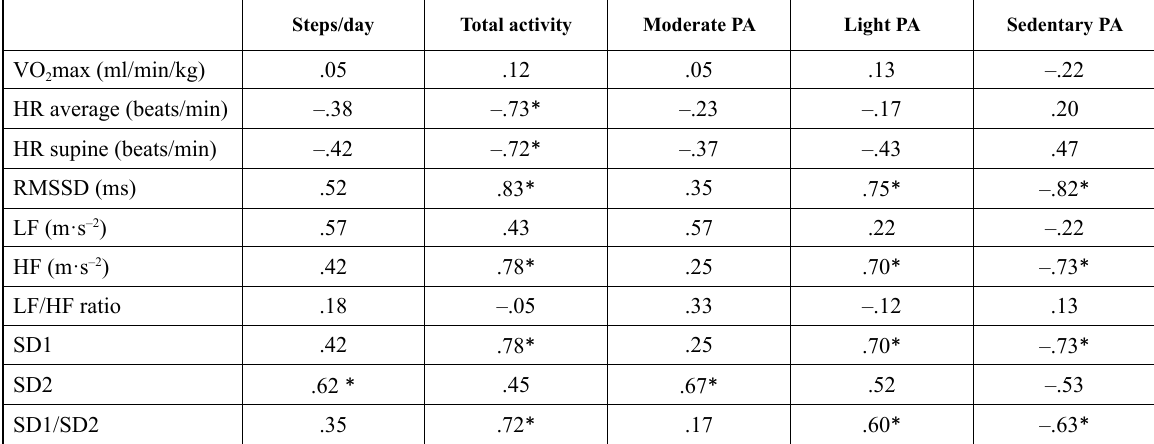
Table 2. Spearman’s correlations between components of physical active, cardiorespiratory fitness and heart rate variability in supine position Steps/day